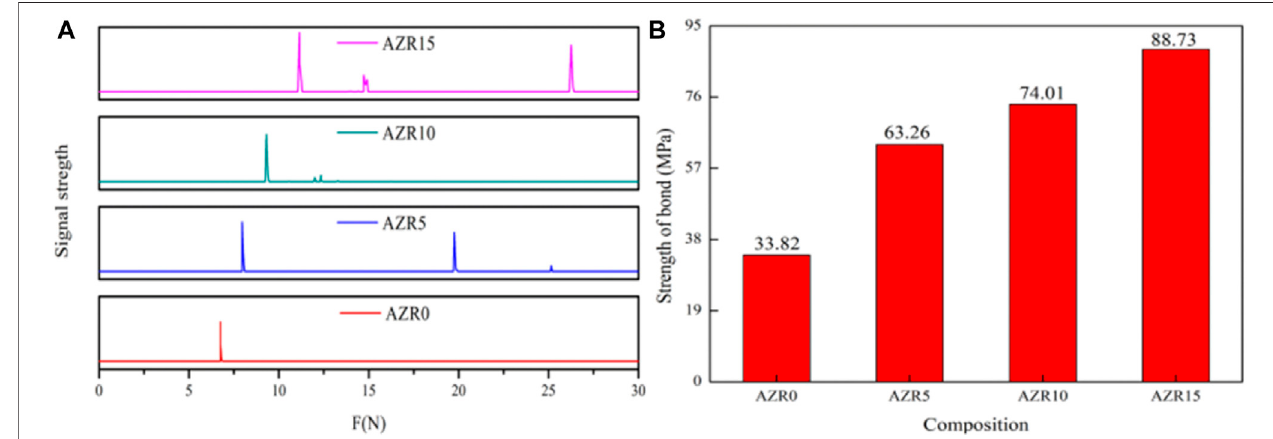
FIGURE 8 | The binding force of the different samples.